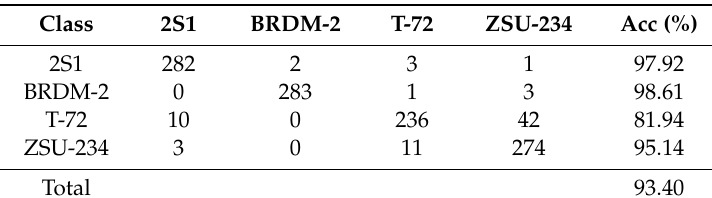
Table 8. Confusion matrix of ESENet under